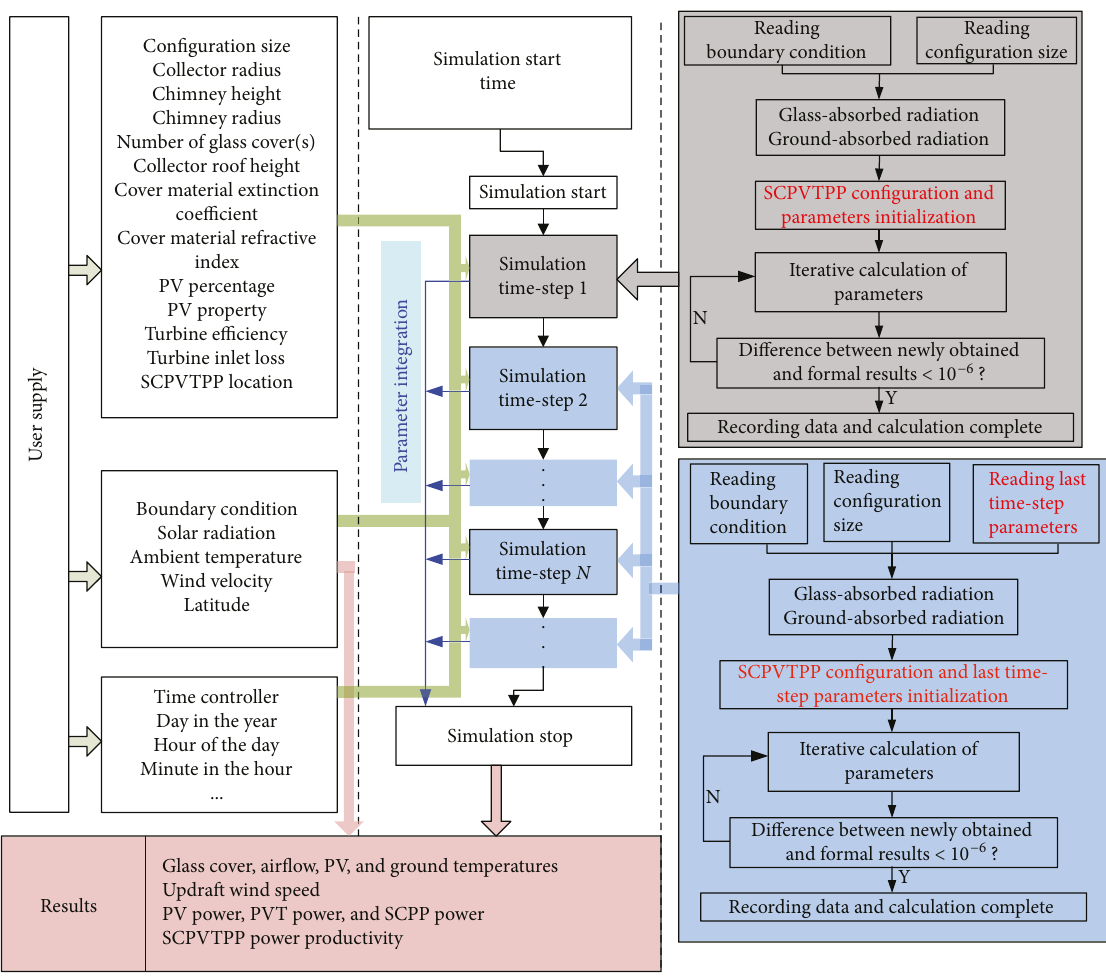
Figure 4: Flowchart of the simulation